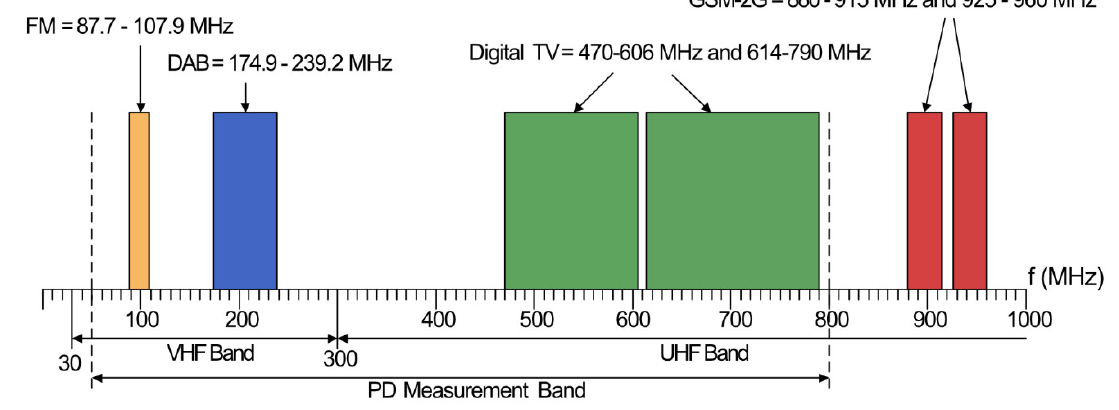
Figure 4. VHF/UHF electromagnetic spectrum with typical wide range transmission signals.